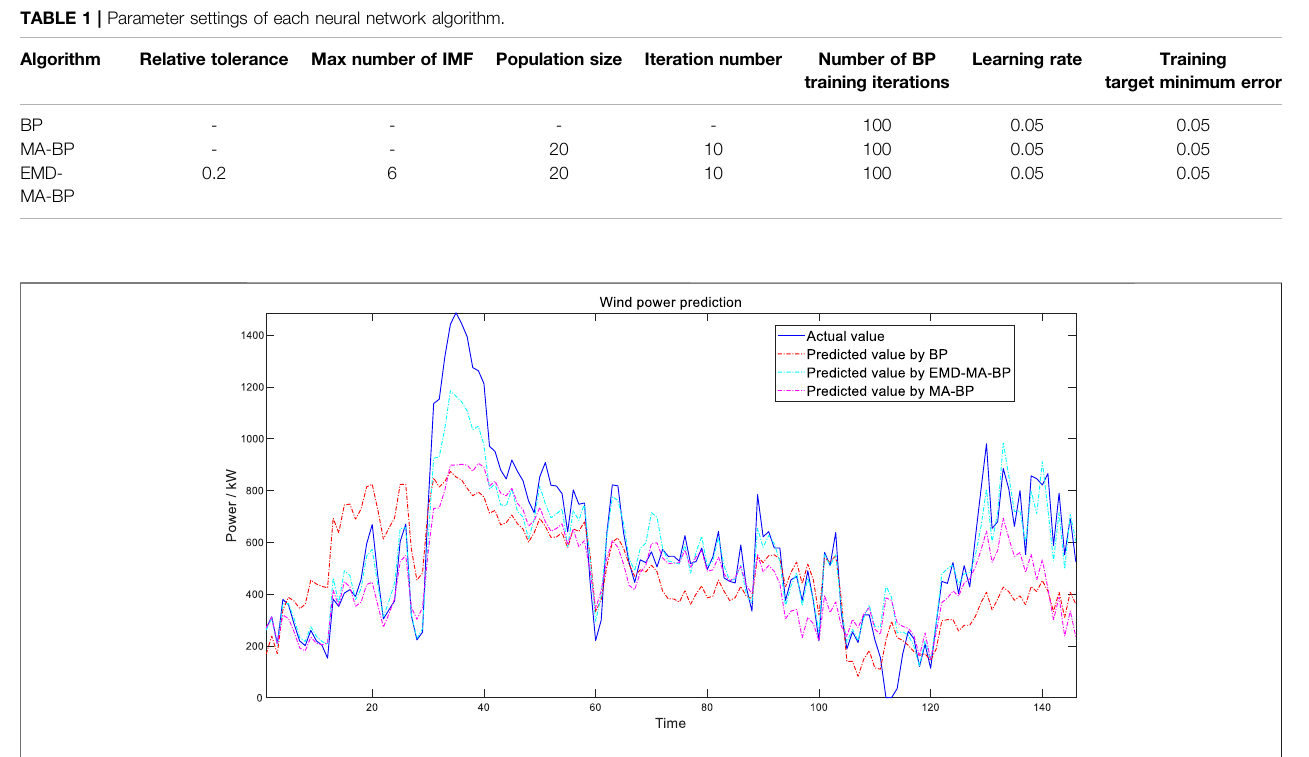
FIGURE 3 | Predicted power curves of three